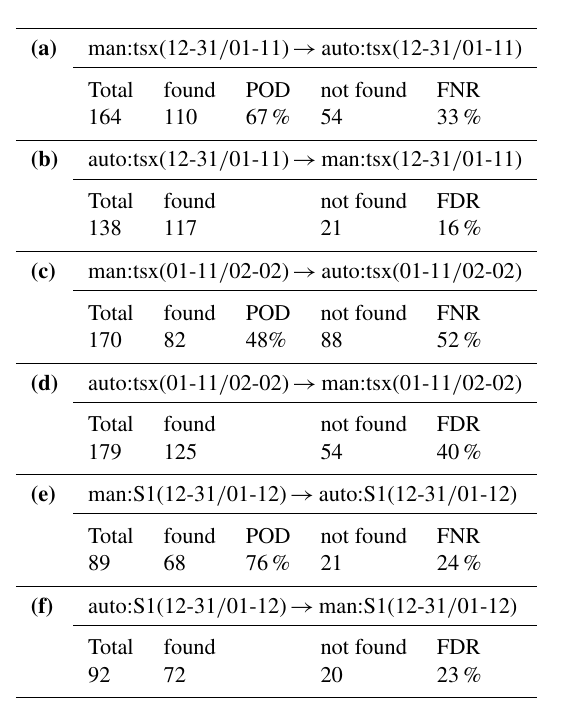
Table 6. Number of automatically detected new avalanches com- pared to the number of manually detected new avalanches.